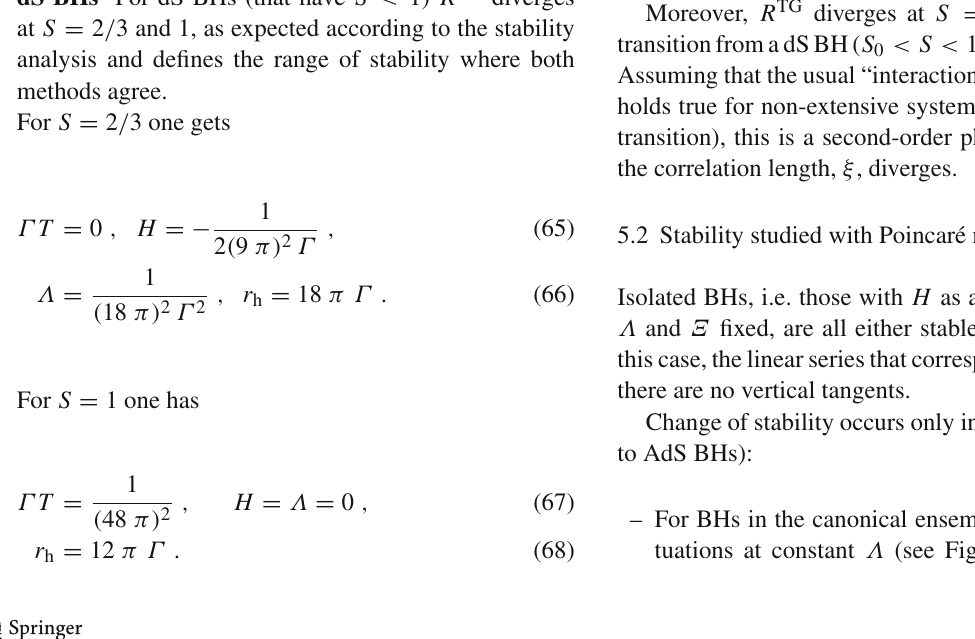
– dS BHs For dS BHs (that have S < 1) R TG diverges at S = 2 / 3 and 1, as expected according to the stability analysis and defines the range of stability where both methods